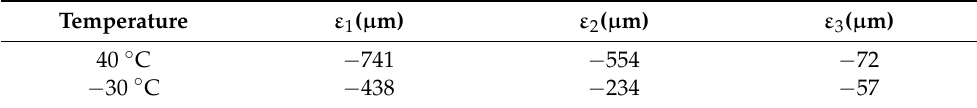
Table 5. Residual strains tested by the through-hole drilling